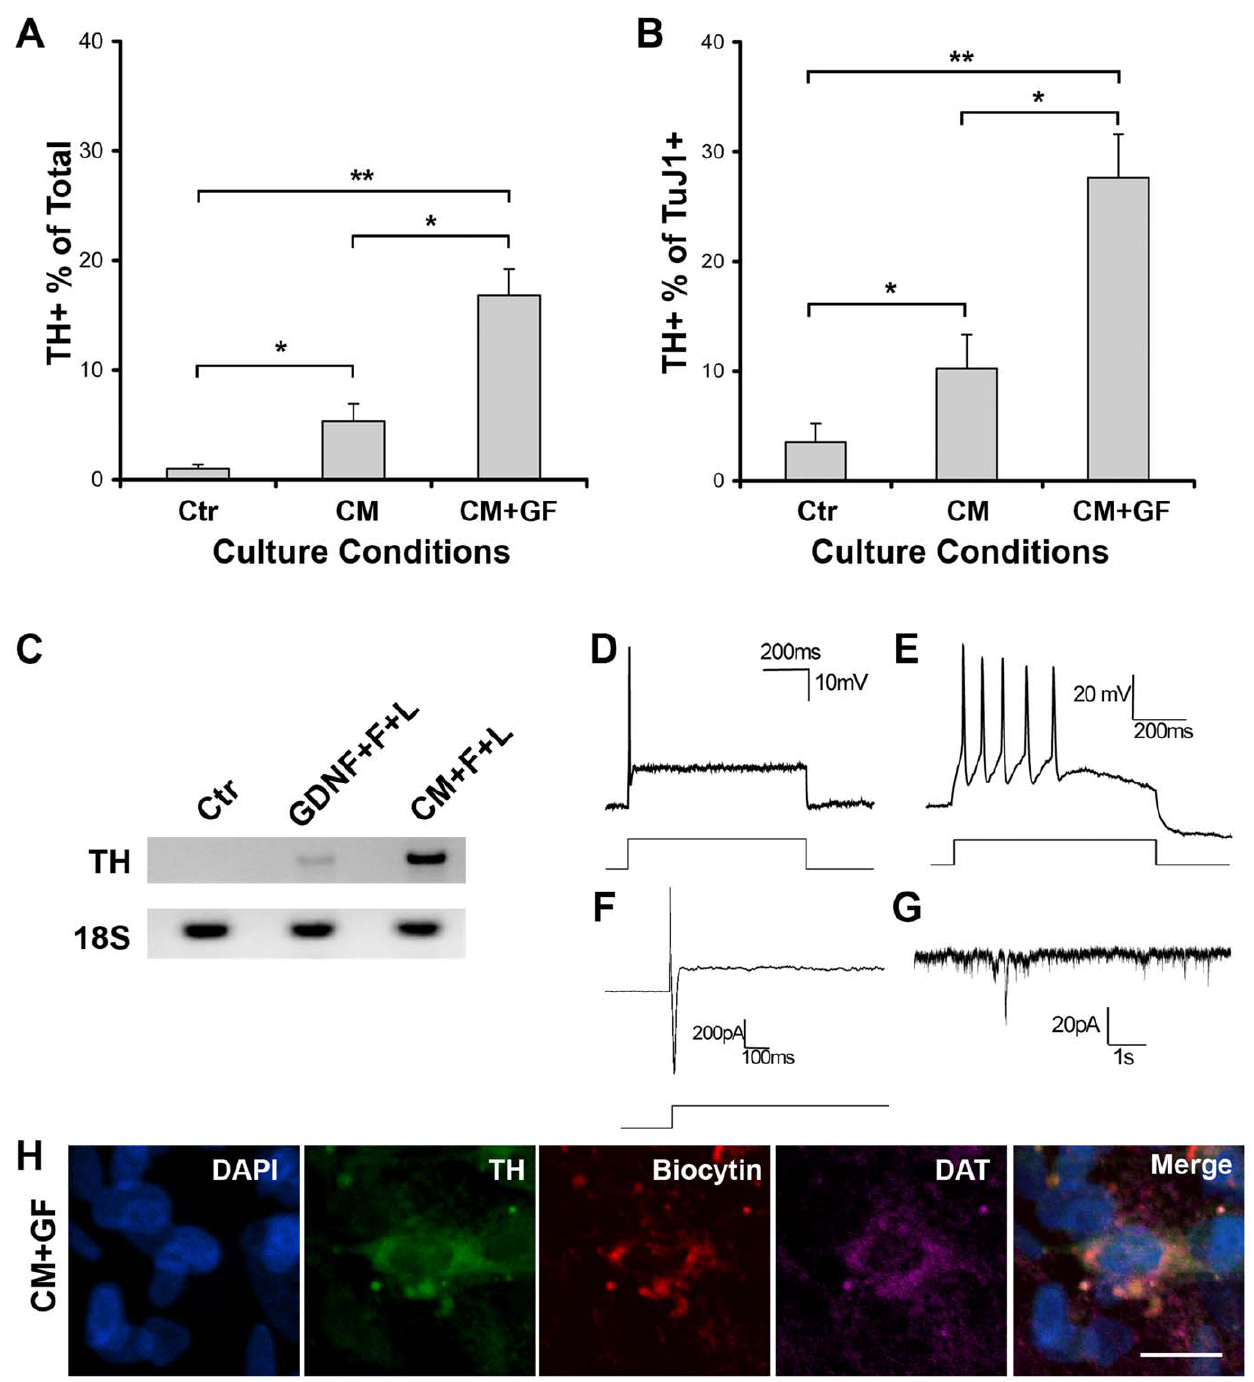
Figure 3. Electrophysiological properties of DA induced neurons. Quantitative analysis of the TH-inductive effects ( A & B ). The TH-IR neurons were expressed as a percentage of total live cells determined by DAPI staining and also as a percentage of the total number of TuJ1-IR neurons. Results are mean 6 S.E.M. of experiments performed three times on independent culture preparations, each performed in duplicate. The TH induction with CM + F + L treatment produced significantly more TH + cells compared to CM treatment alone (* P , 0.01) and to non-treated control (** P , 0.001). ( C ) The relative abundance of TH and 18 S transcripts was assessed by RT-PCR (see Materials and Methods section for the description of the primers used and the PCR conditions) in control (Ctr), GDNF + bFGF (F) + LIF (L) and in CM + F + L treated cultures (line + ) which showed a strong induction of TH in CM + F + L culture condition. ( D ) Representative current clamp trace of action potentials elicited in response to a 400 pA current injection from a neuron. ( E ) Example of action potential burst in response to 400 pA current injections. ( F ) Voltage-activated sodium and potassium currents elicited in response to a 2 50 mV step. (G) Sample trace of spontaneous EPSCs in a neuron held at 2 70 mV. ( H ) Triple labeling immunocytochemical process of hNSC culture used for electrophysiological recording showing the co-localization of TH with biocytin and DAT. Scale bar is 20 m m (H).